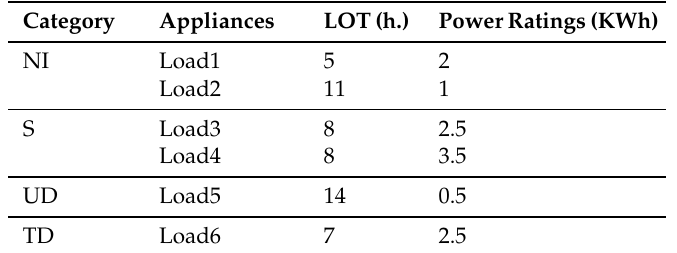
Table 3. Appliance parameters detail used in the simulation process